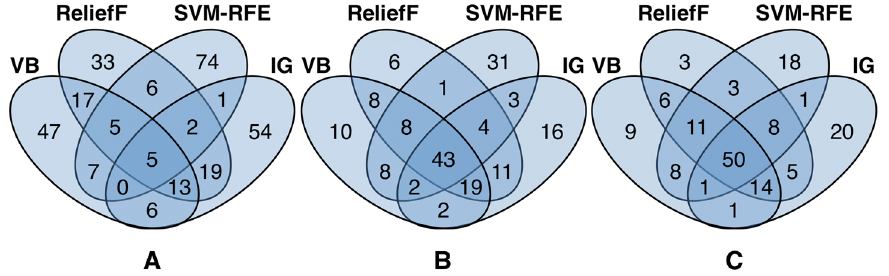
Figure 10: Overlaps of the top 100 genes selected by (A) traditional gene selection, (B) data filtering, and (C) gene filtering